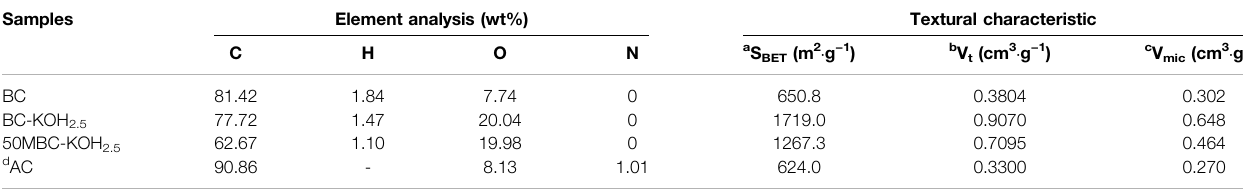
TABLE 1 | Elemental analysis and textural characteristics of BC, BC-KOH 2.5 , 50MBC-KOH 2.5 and coconut shell activated carbon (Ji et al., 2010). Samples Element analysis (wt%) Textural